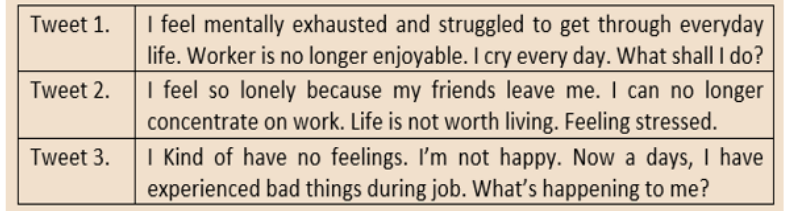
Figure 2. Some depressive sentences and words from dataset.